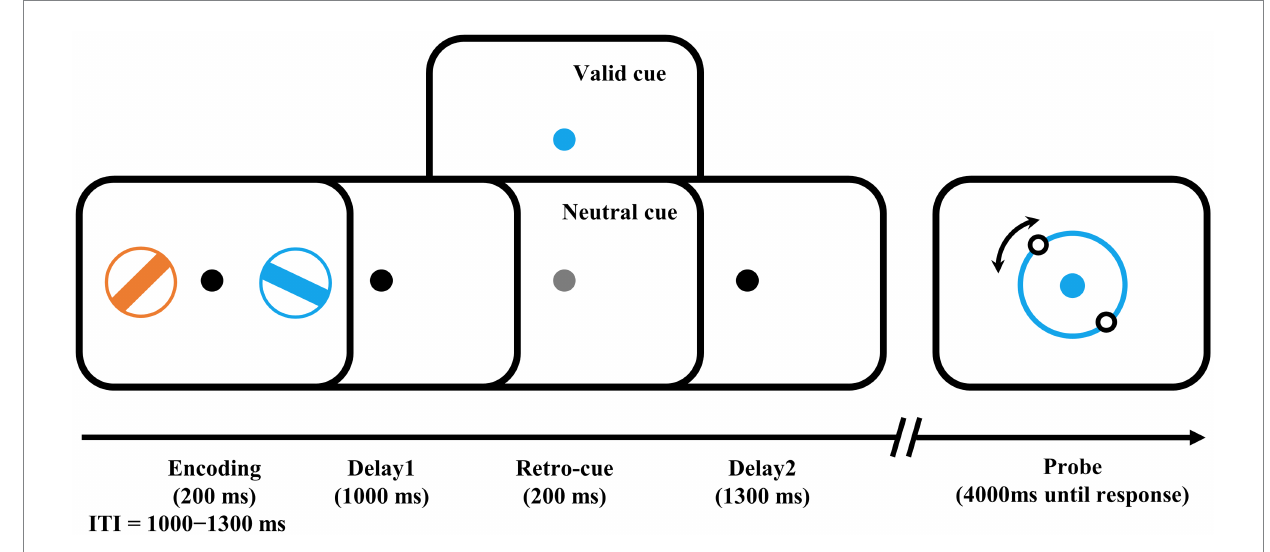
FIGURE 1 Examples of trial schedule and experimental design. The number of valid cues and neutral cues were equal. Participants needed to rotate the illusory orientation of the two dots on the probe ring to the orientation of the target bar, i.e., the bar in the encoding phase with the same color as the probe ring. ITI, intertrial